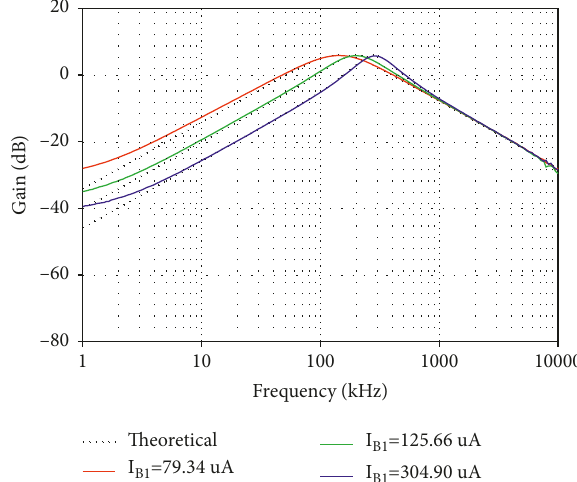
Figure 12: Experimental magnitude frequency response of BP function when I B 1 is varied.